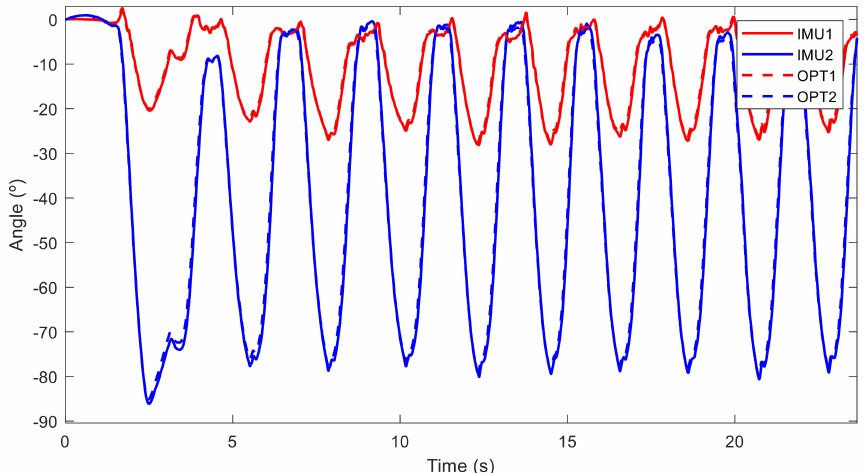
Figure 11. Angles measured by sensors in the sagittal plane from a man with experience C performing deadlifts without a neutral spine position. IMU1 and IMU2 are the measurements from inertial sensor 1 (at L5) and sensor 2 (T8), respectively, and OPT1 and OPT2 are the measurements from optical motion system and markers situated at L5 and T8,